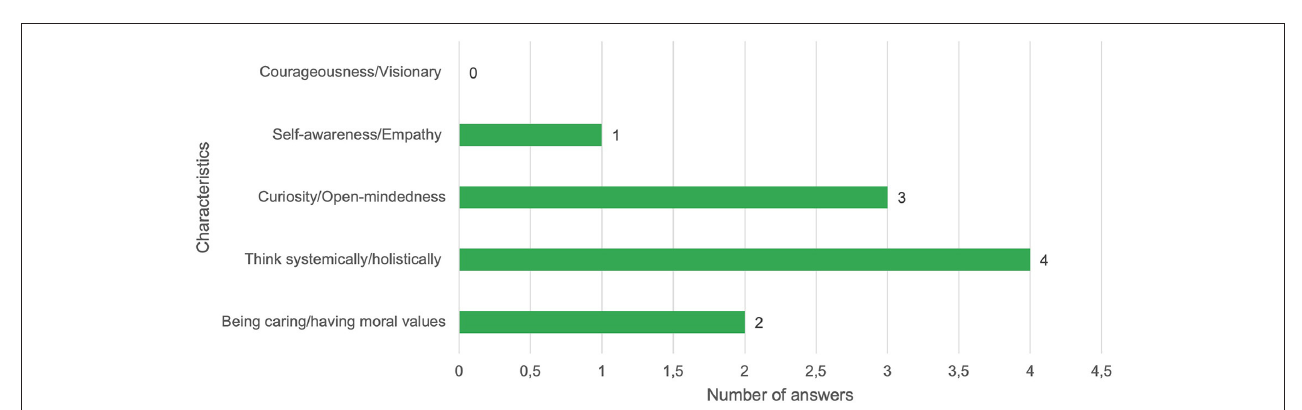
FIGURE 5 | Sustainability